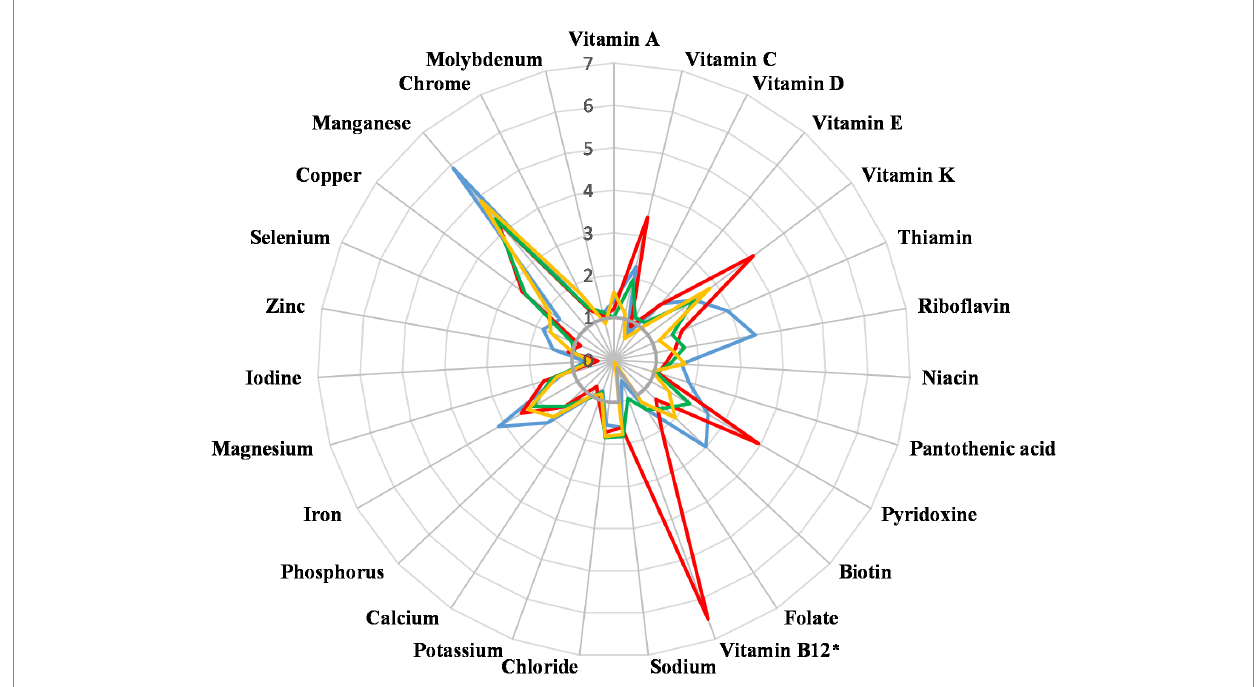
FIGURE 4 Micronutrient intake in multiples of Slovene Reference Values [SRV, (11)]. *Vitamin B 12 values were divided by 20 to fit in the chart. Blue—Low carbohydrate high fat, red—Vegan, green—Vegetarian,